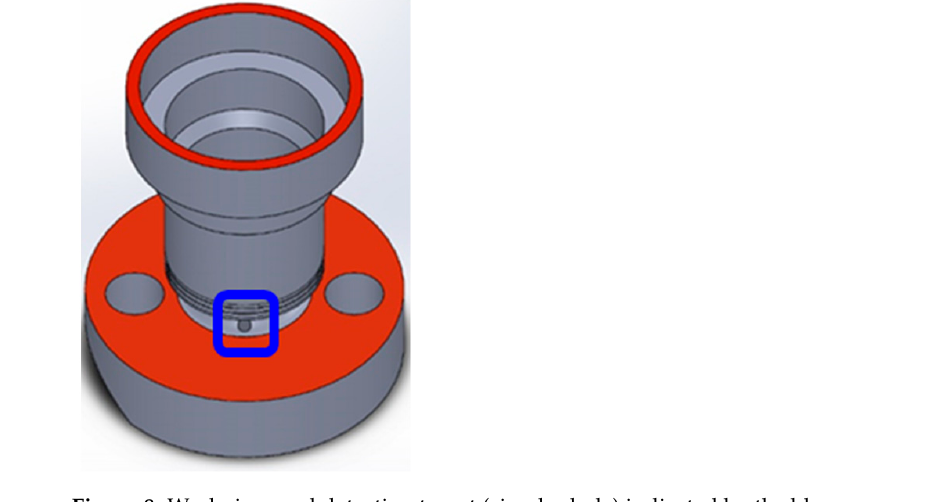
Figure 9. Illustration of the camera and light source positioning. 3.2. Dataset The original image size was 1280 × 550 pixels (Figure 10). The focuses of okay (OK) and not good (NG) images are shown in the green and red boxes, respectively, in Figure 11. After obtaining 300 OK and 300 NG images, we cropped the images to 186 × 189 pixels and used them for training. We defined rough surfaces (e.g., the irregular white parts in the red boxes in Figure 11) as defects.